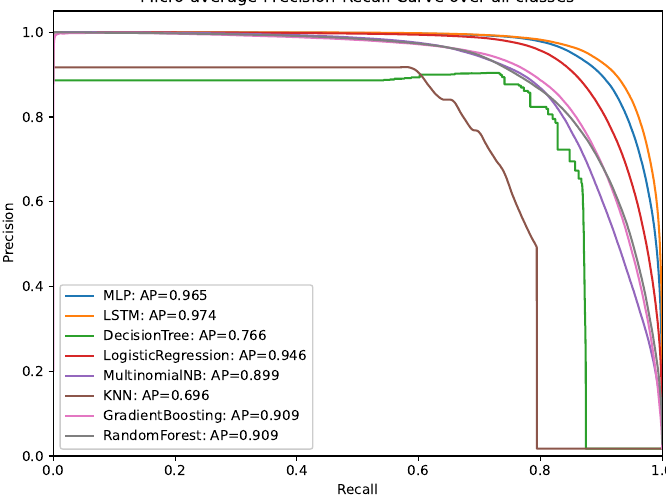
Figure 5. Precision-recall curves.